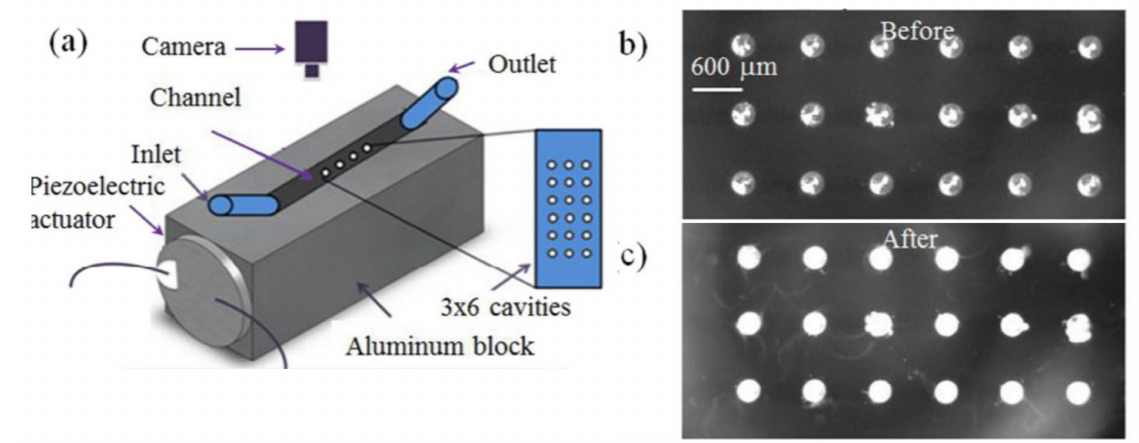
Figure 37. ( a ) Device schematic for microbubble-based acoustic separation of C. elegans . ( b ) Microbub- ble formed and no worm trapped before the acoustic excitation is turned on. ( c ) Trapping of worms towards the bubble when the acoustic transducer is turned on [338]. Reproduced with permission from Yuhao Xu et al., Applied Physics Letters; published by AIP Publishing,